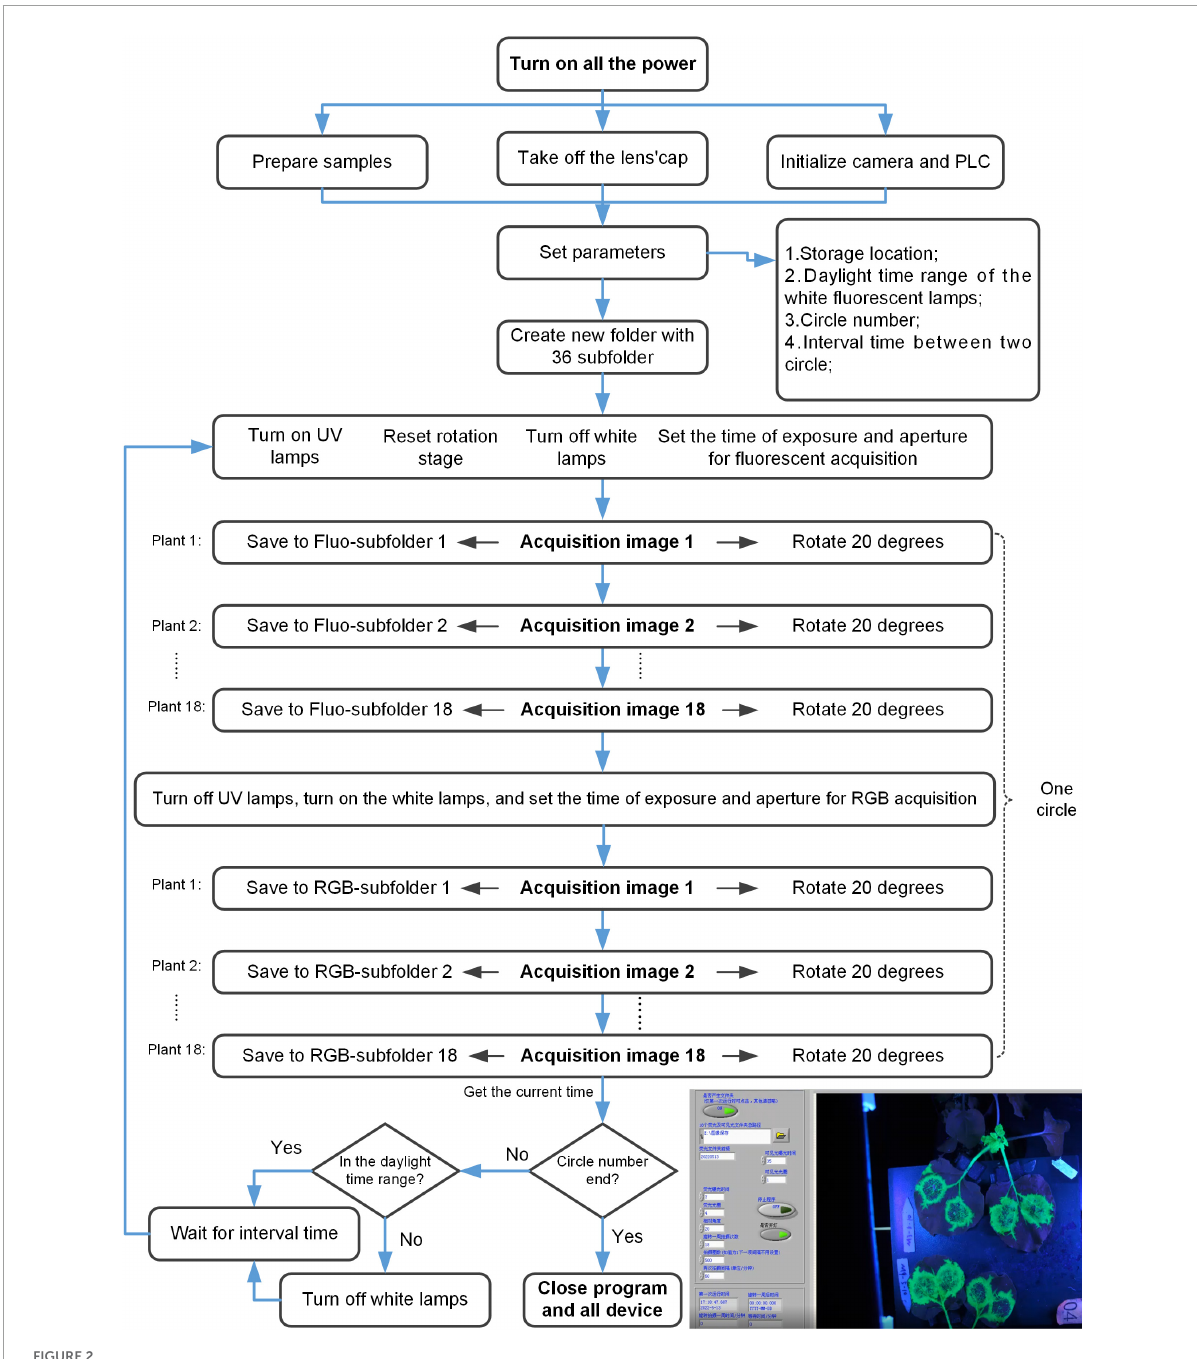
Figure 2 would goes through all the steps in Figure 3 . The detailed flowchart included the following steps. (1) Load the MAID Module of the digital camera. (2) Initialize the Module Obj of the digital camera. The MAID Module was downloaded from the official website of digital camera. (3) Initialize the digital camera, and waiting for the command. (4) Set the